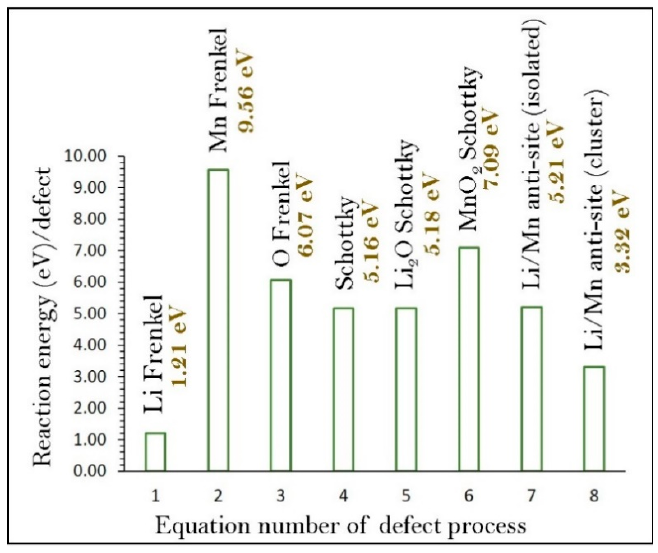
Figure 2. Energetics of intrinsic defect process calculated in monoclinic Li 2 MnO 3 .